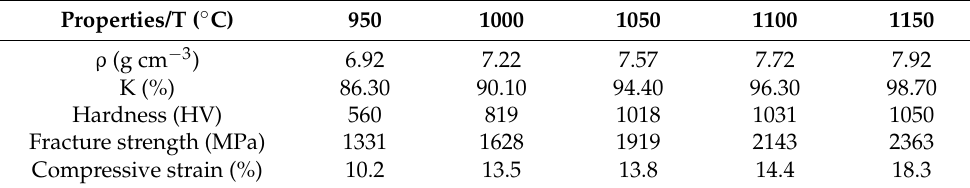
Table 7. The mechanical properties of HEA blocks sintered at different